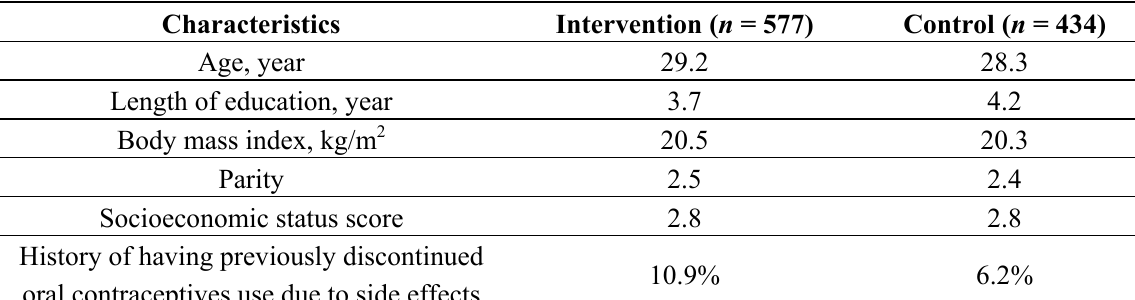
Table 1. Baseline characteristics by group.